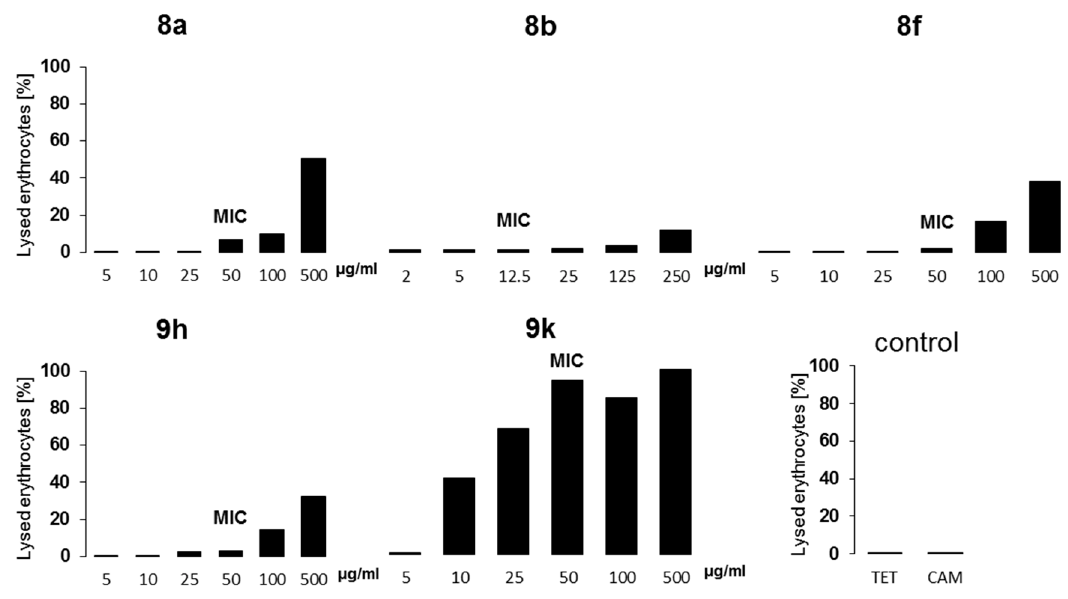
Figure 2. Haemolytic activity of compounds 8a , 8b , 8f , 9h and 9k . Tetracycline (TET) and chloramphenicol (CAM) in MIC concentrations were used as a control.